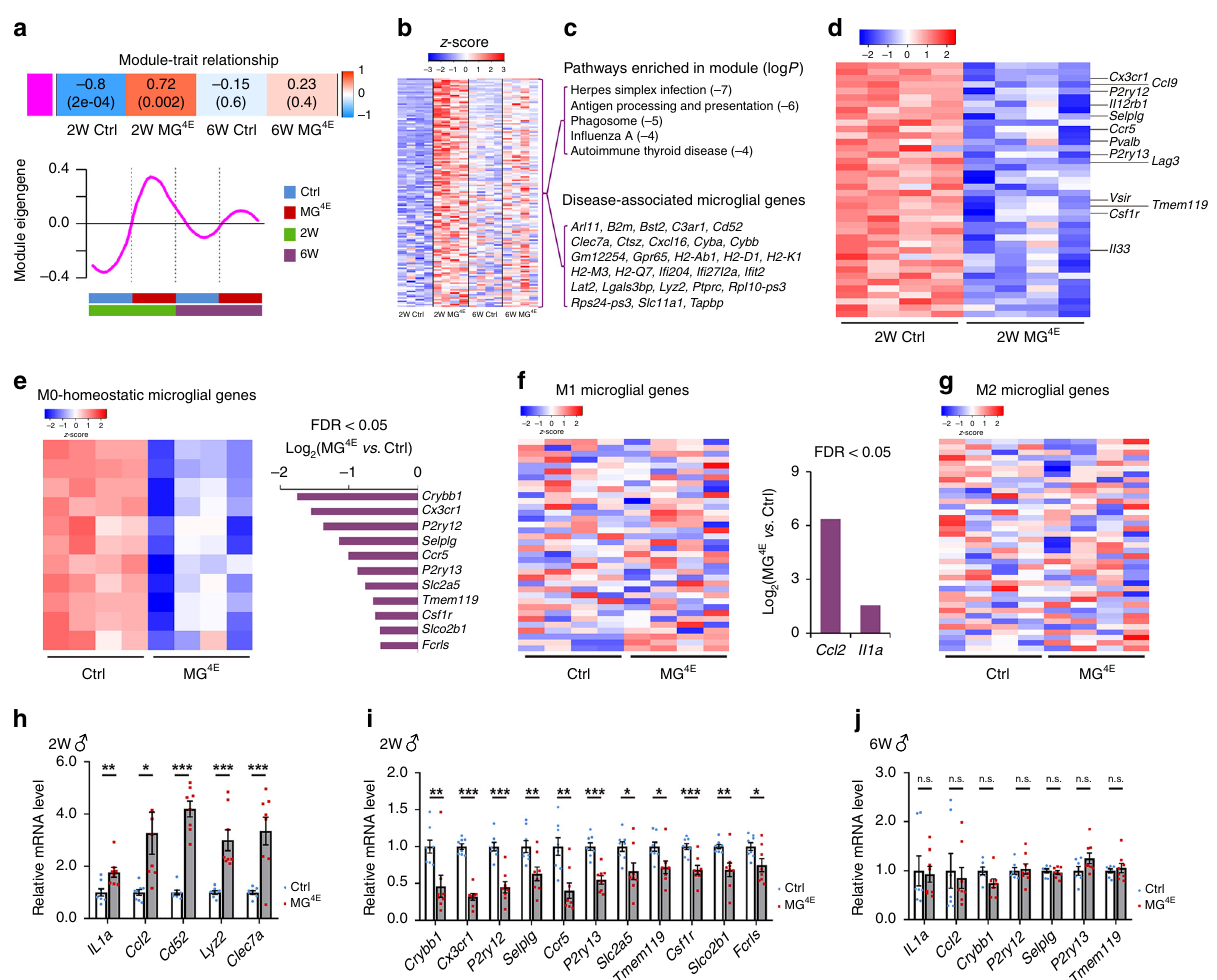
Fig. 7 Gene expression pro fi les in male control and MG 4E mice. RNA-seq was performed using RNA samples isolated from hippocampi of 2-week-old (2 W) and 6-week-old (6 W) male control (Ctrl) and MG 4E mice. a (top) Heatmap showing module-trait relationship of magenta module. Correlation coef fi cients between a module eigengene and trait (coded from − 1 to 1) and corresponding p values (two-sided Student asymptotic p value for a given correlation was calculated using corPvalueStudent in WGCNA package) are shown in each cell. The color indicates the level of correlation. (bottom) Plot showing the expression of the module eigengene across sample categories. b Heatmaps of genes (138 genes) within magenta module. c Selected KEGG pathways and disease-associated microglial genes enriched in magenta module (log P values adjusted with Benjamini correction). d Heatmaps of downregulated genes (FDR < 0.05) in 2-week-old MG 4E mice. (e Heatmaps of downregulated M0-homeostatic microglial genes in 2-week-old MG 4E mice. f , g Heatmaps of top 40 M1 ( f ) and M2 ( g ) microglial genes in 2-week-old MG 4E mice (Ctrl and MG 4E , n = 4 mice). h , i RT-PCR validation of selected upregulated ( h ) and down-regulated ( i ) genes in hippocampi of 2-week-old male MG 4E mice. n = 8 per genotype. * p < 0.05, ** p < 0.01 and *** p < 0.001 by two-sided t -test. j RT – qPCR validation of selected genes in hippocampi of 6-week-old male MG 4E mice. n = 7 control mice and 8 MG 4E mice. n.s. not signi fi cant by two-sided t -test. All data are shown as mean ± s.e.m. Source data are provided as a Source Data fi